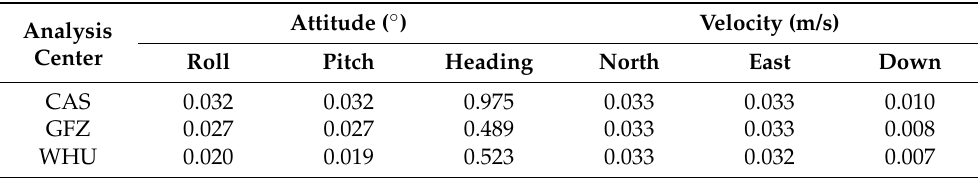
Figure 11. Distribution of the offsets in roll ( top ), pitch ( middle ), and heading ( bottom ) of the G + B SF-PPP/INS tight integration using the real-time products from CAS, GFZ, and WHU. Table 6. RMS of attitude and velocity offsets of SF-PPP/INS tight integration using the real-time products from CAS, GFZ, and WHU.